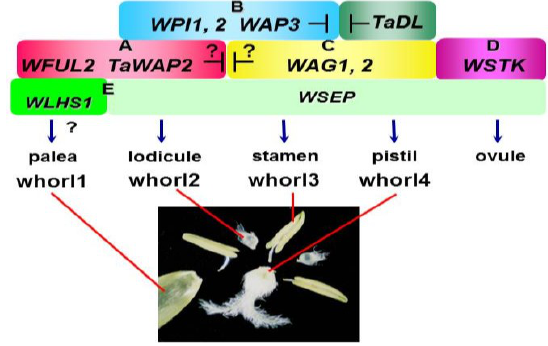
Figure 3. The ABCDE model of floral organ formation in wheat. In contrast to the Arabidopsis ABCDE model, the wheat ABCDE model involves duplicated genes for class B ( PI -like) and class C ( AG -like) functions. Furthermore, class E genes are divided into two groups, WSEP and WLHS1 , with sub-functionalization. A YABBY gene TaDL specifies the pistil (carpel) identity. The pistillody line has been valuable for constructing the ABCDE model in wheat. The wheat ABCDE model is similar to that of rice except for the class A genes. The current wheat ABCDE model indicates that class B and TaDL proteins show mutual suppression, which was suggested from analysis of a pistillody line. The mutual suppression between class A and C genes is also postulated here. The wheat ABCDE model probably functions through complex homoeologous gene interactions.